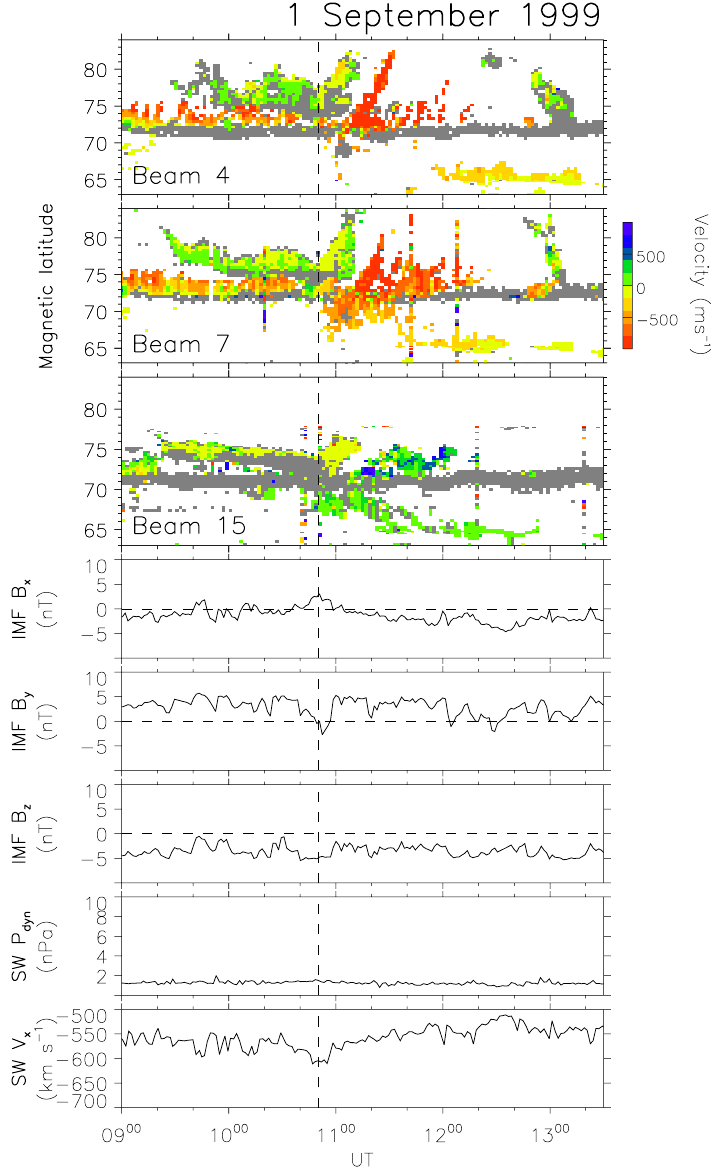
Fig. 6. Similar to Fig. 2, though for the 1 September 1999 interval. The top three panels indicate line-of-sight plasma drift from three different beam